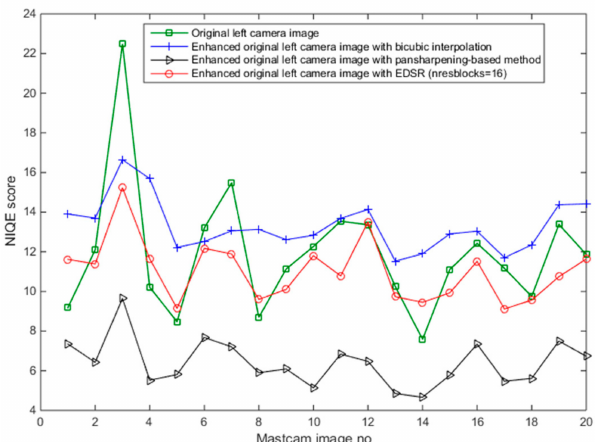
Figure 15. Natural image quality evaluator (NIQE) metric results for enhanced “original left Mastcam images” (scale: × 2) by the bicubic interpolation, pansharpening-based method, and EDSR (nresblocks = 16).